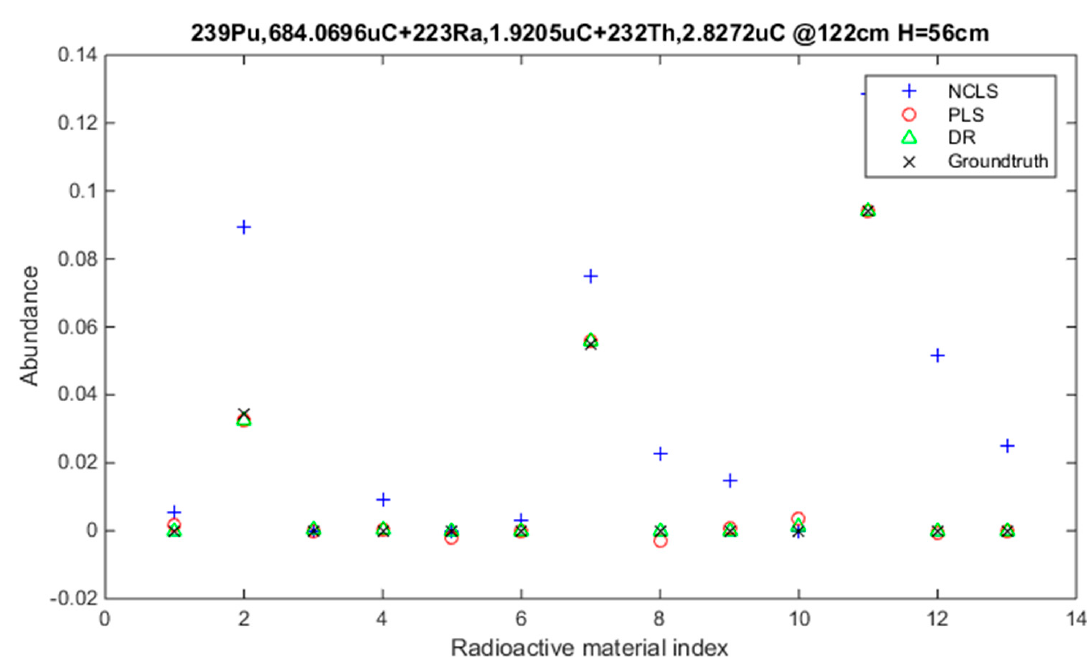
Figure 13. Three-source mixture example from low-mixing-rate dataset when foreground spectrum is used for mixing-rate Figure 13. Three ‐ source mixture example from low ‐ mixing ‐ rate dataset when foreground spectrum is used for mixing ‐ estimation (RMSE values: NCLS: 0.0260, PLS: 0.0016, DR: rate estimation (RMSE values: NCLS: 0.0260, PLS: 0.0016, DR: 0.0007).